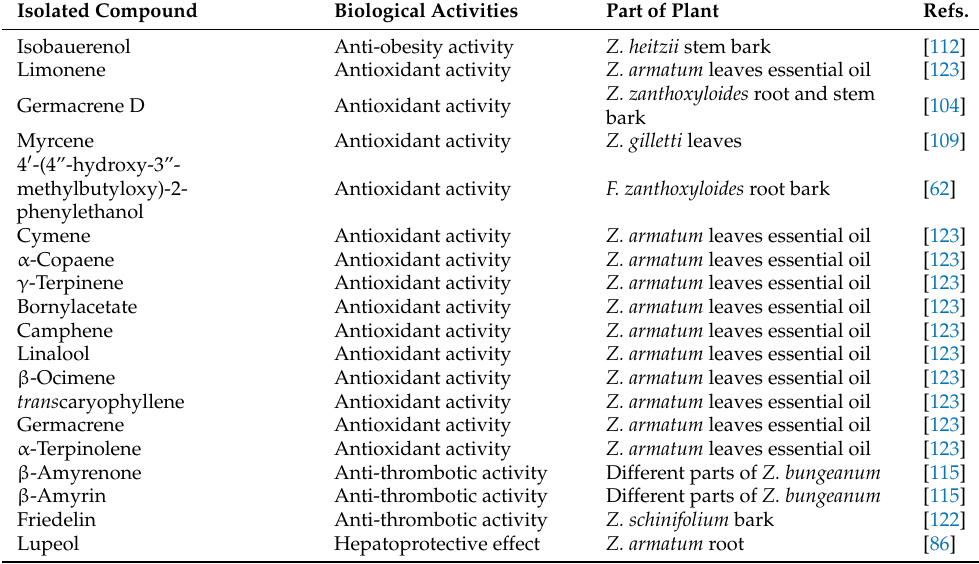
Table 5. Terpenes and their derivatives isolated from Zanthoxylum species with anti-obesity, antioxi- dant, anti-thrombotic and hepatoprotective